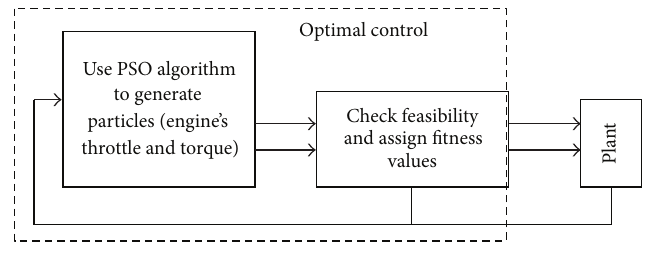
Figure 4: Structure of the optimal control.